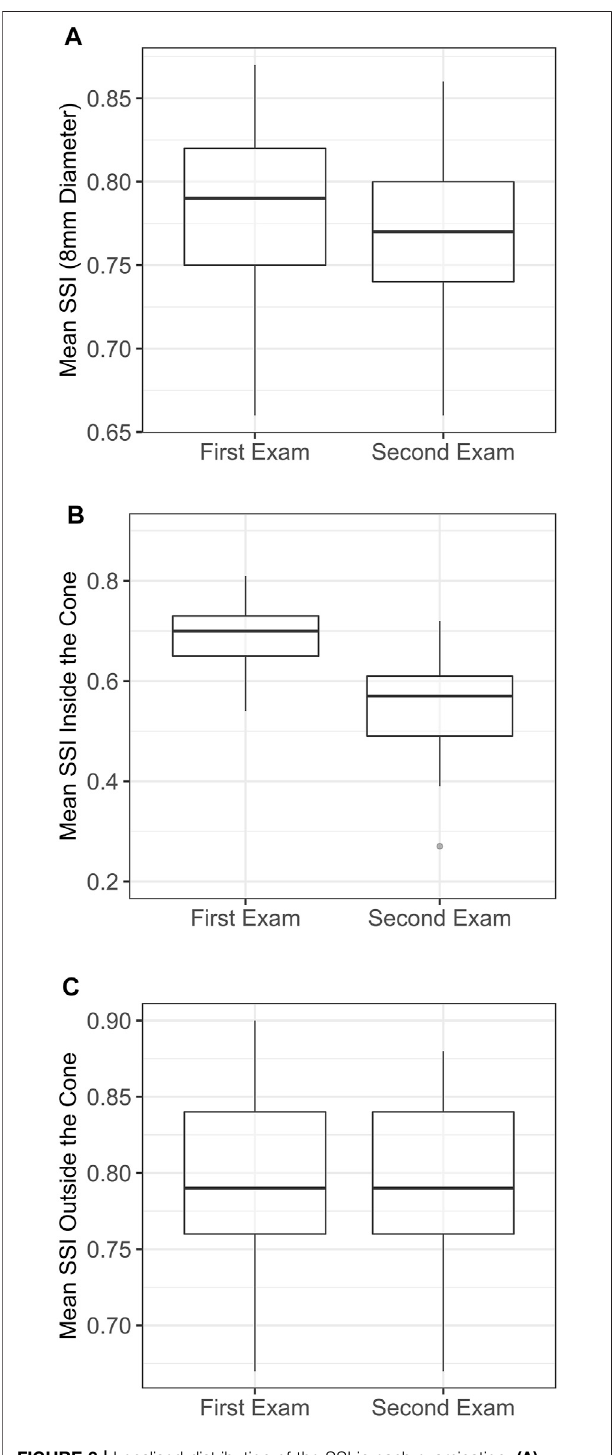
FIGURE 3 | Localised distribution of the SSI in each examination. (A) Mean SSI over 8 mm diameter. (B) Mean SSI inside the cone area. (C) Mean SSI outside the cone area. SSI, stress-strain